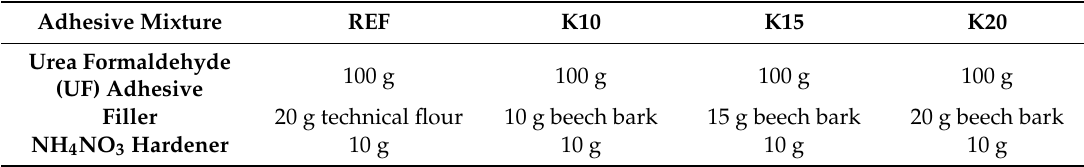
Table 1. Composition of tested adhesive